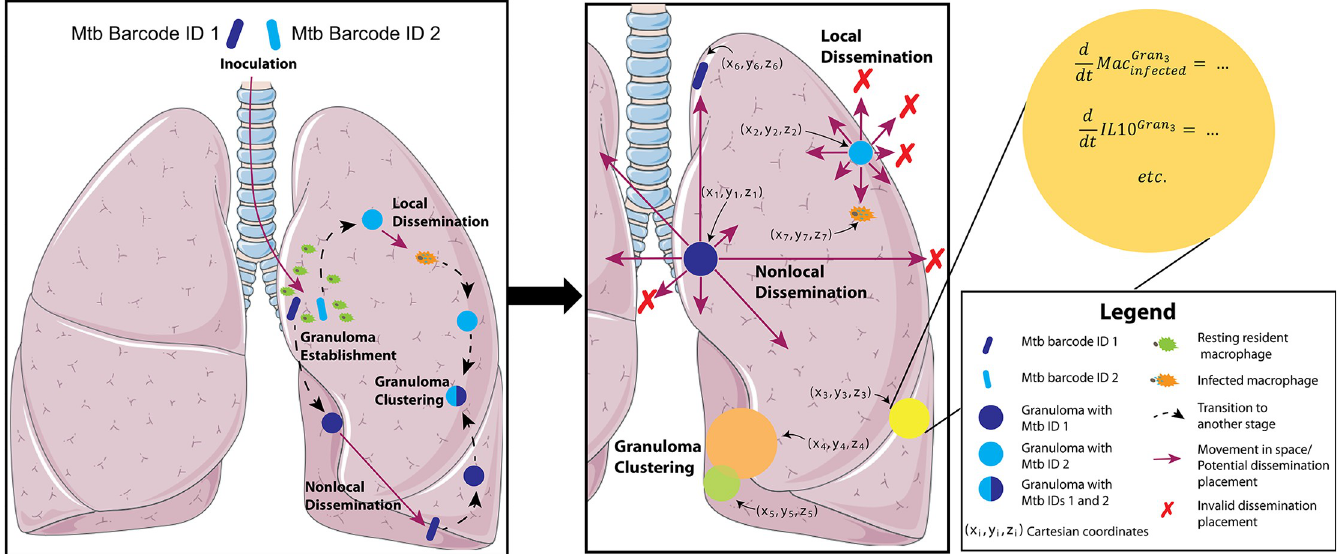
Fig 2. Process of Mtb infection and rules for granuloma dissemination and location within MultiGran . A non-human primate is inoculated with Mtb, here tracked using different “barcodes” or IDs. These Mtb are taken up by resident macrophages, initiating an innate immune response. This response includes the secretion of various cytokines and chemokines that help prime and/or recruit other immune cells to the site of the infection, resulting in the formation of lung granulomas. The dynamics within each granuloma are governed by systems of ordinary differential equations. Occasionally, as a granuloma develops, it may disseminate—either locally or non-locally. In local dissemination, an Mtb-infected macrophage moves to another nearby location within the same lung lobe. In non-local dissemination, a free extracellular Mtb reaches the airways or is carried to a draining lymph node and then deposited at a site not necessarily near the original location; i.e., in a different lung lobe. The (x,y,z) positions of disseminated granulomas depend on the method of dissemination (i.e., local or nonlocal) and the position of the parent granuloma. Granuloma clusters can form when granulomas develop near each other and may grow into each other, or when one granuloma forms immediately adjacent to the original granuloma via local dissemination [3]. Granuloma clusters may contain more than one Mtb ID.